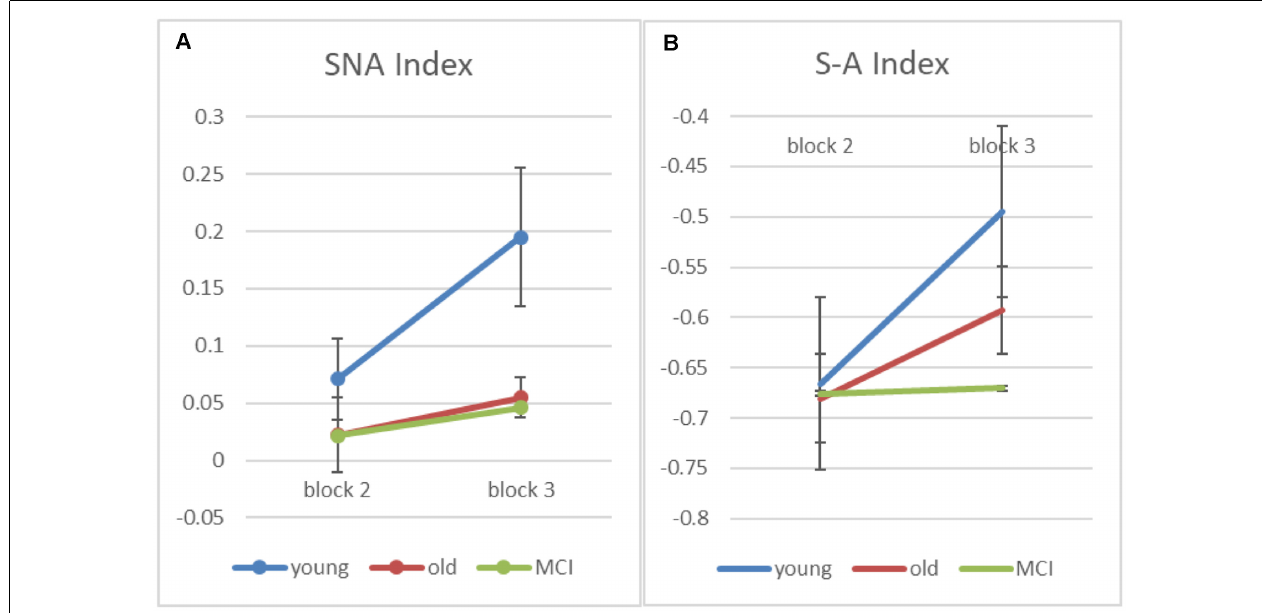
FIGURE 5 | (A) Input-based clustering score counting only semantic non-adjacent (SNA) transitions for blocks 2 and 3 (error bars correspond to standard errors of the mean). (B) A computed score—“Semantic minus Adjacent” (S − A) index, which subtracts adjacent non-semantic transitions from the number of semantic non-adjacent ones (and divides by the number of transitions in each